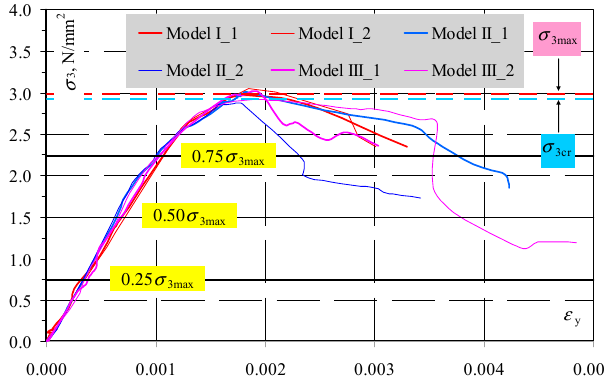
Figure 9. Relationships between stress and strain σ - ε for all tested models.